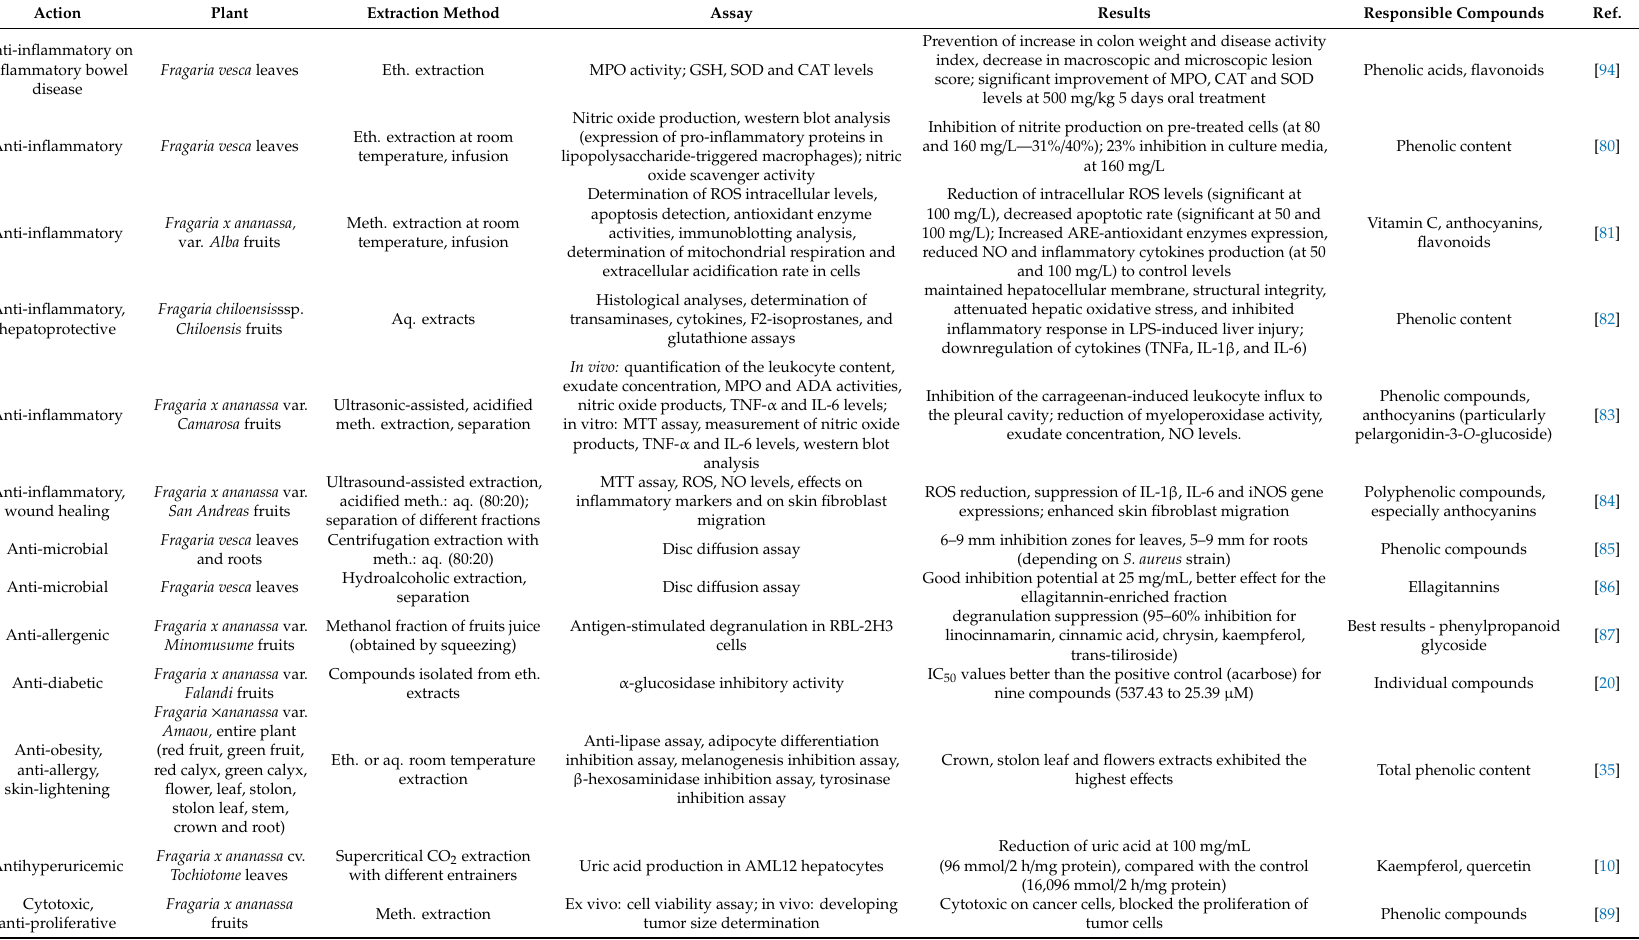
Table 4. Main biological activities presented in the literature (references listed in chronological